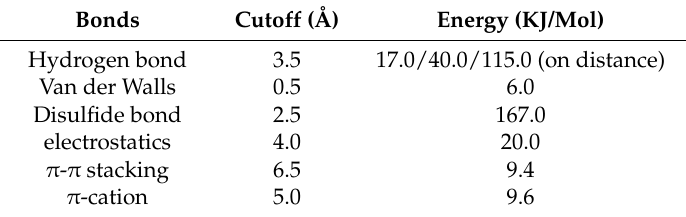
Table 6. The type of interaction bonds and their energetic parameters used in defining protein amino-acid interaction